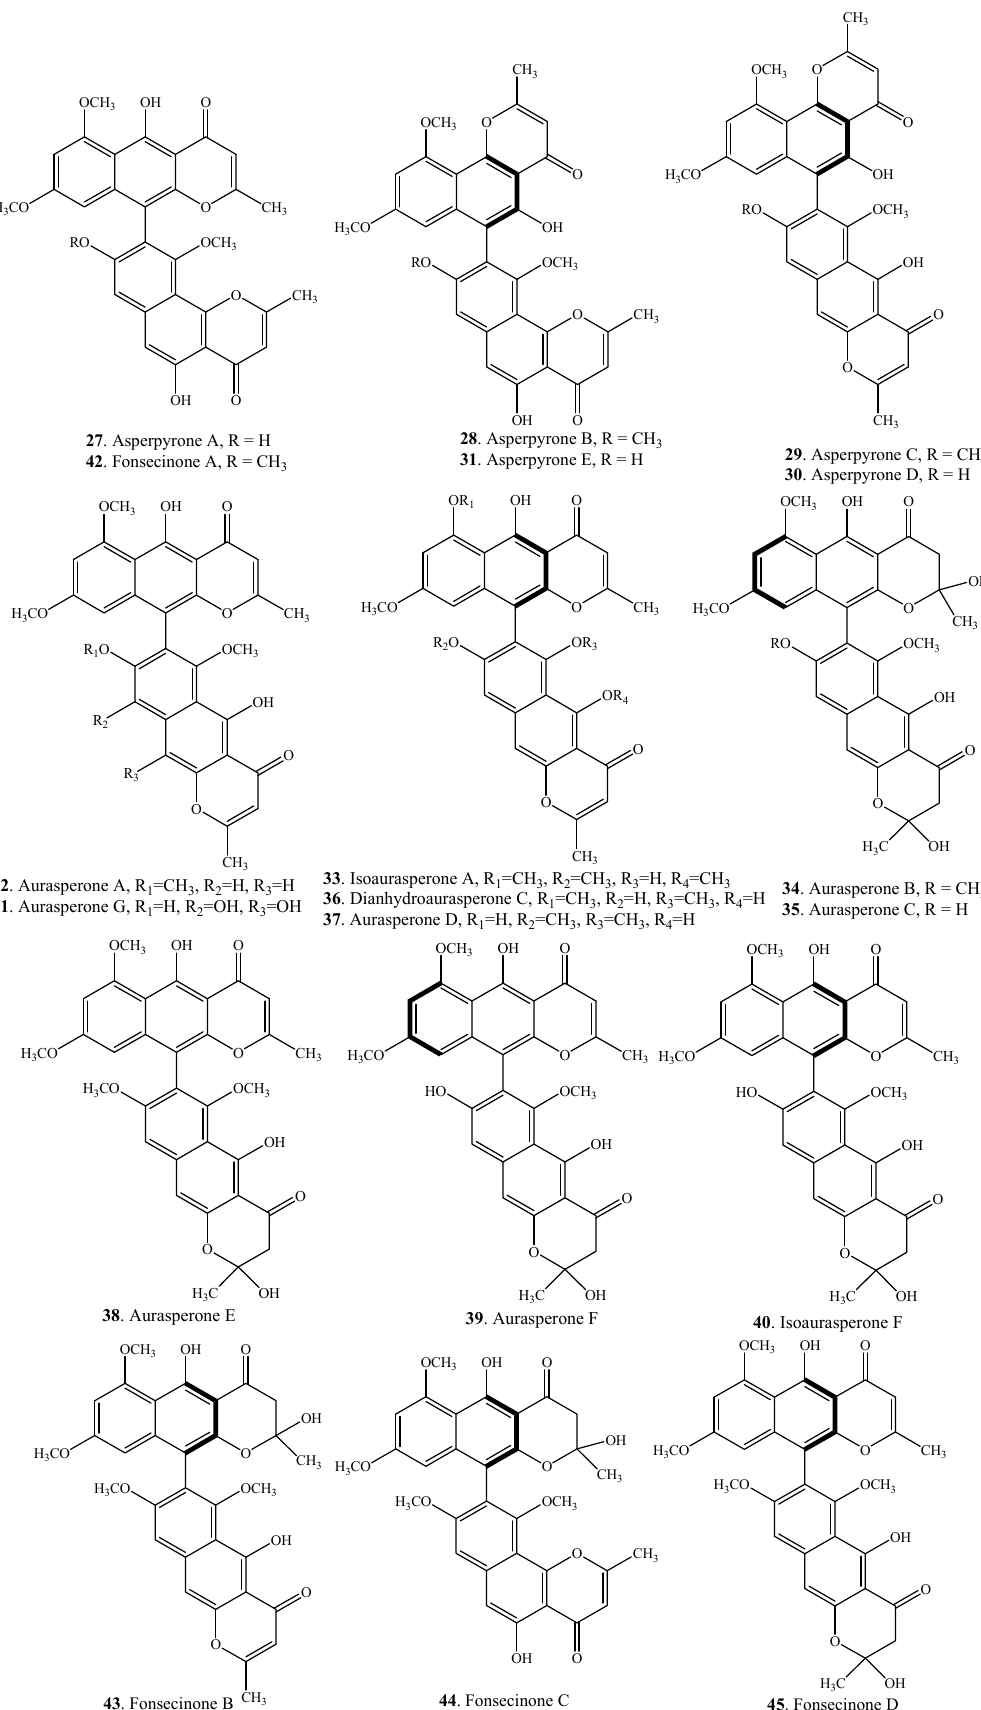
Figure 2. Structures of asperpyrone-type bis-naphtho- γ -pyrones ( 27 – 53 ) from fungi.